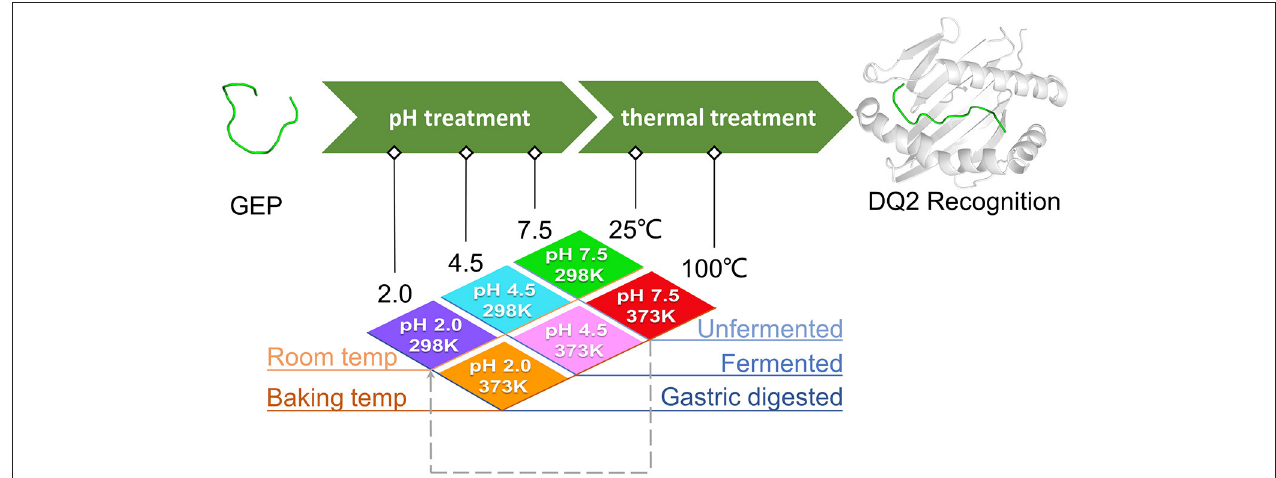
FIGURE 2 | Study rationale and scheme of different treatments on the gluten epitope peptides (GEPs). The native gluten protein (pH 7.5 at 25 ◦ C), with GEP sequences on it, went through low pH treatment (pH 4.5 during bacterial fermentation and pH 2.0 during gastric digestion in the fasted stomach) and thermal treatment (100 ◦ C during boiling/steaming) under different circumstances. The pH and temperature conditions in all scenarios were simplified into a combination of temperatures (298.15 and 373.15K) and pH (2.0, 4.5, and 7.5). Each GEP went through a treatment of one of the above combinations. The dashed arrow represents the case where the dough was treated at pH 7.5 and 100 ◦ C before taken in the diet (pH 2.0 and 25 ◦ C). The conformation of GEPs after the above seven treatments was applied for recognition by HLA-DQ2, and the molecular docking parameters generated served as indicators for their immunogenicity.